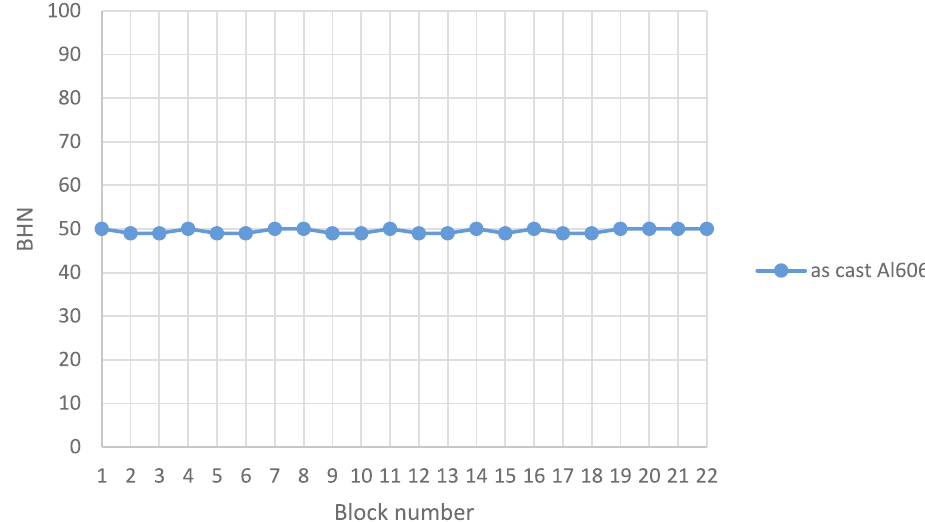
Fig. 7. Hardness distribution in homogenized alloy from bottom to top of casting.